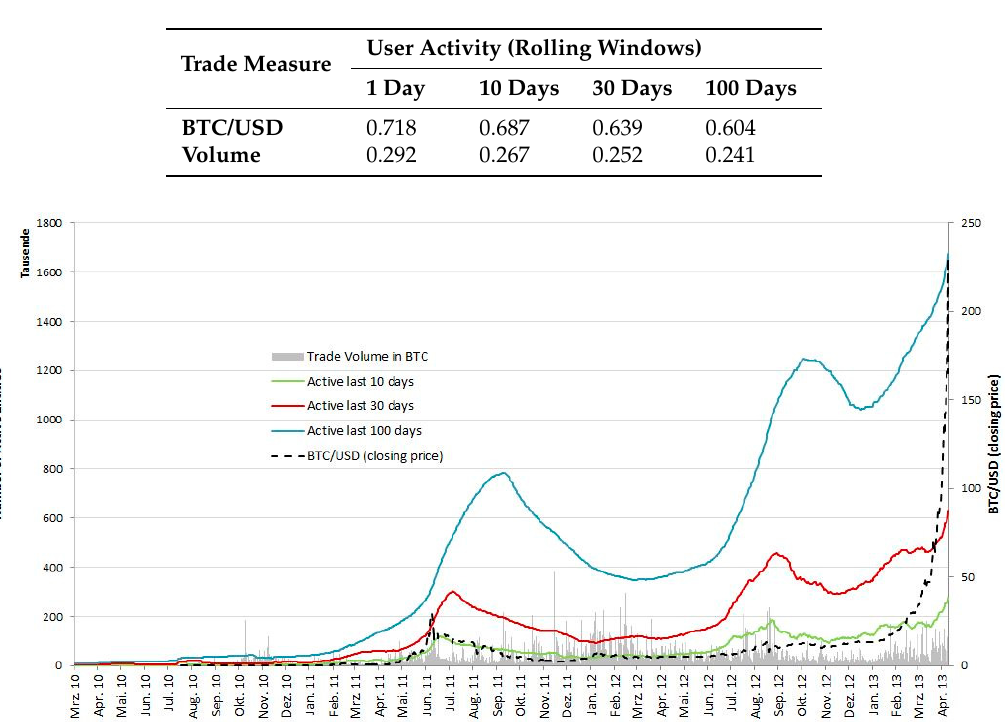
Table 2. Correlation Matrix (User Activity and Trade Behavior).